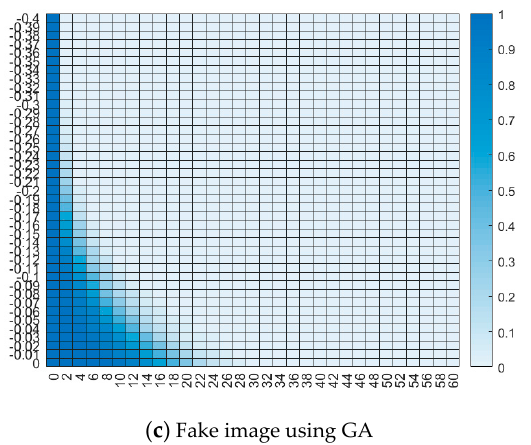
Figure 14. Real/fake detection accuracy. Figure 14. Real / fake detection